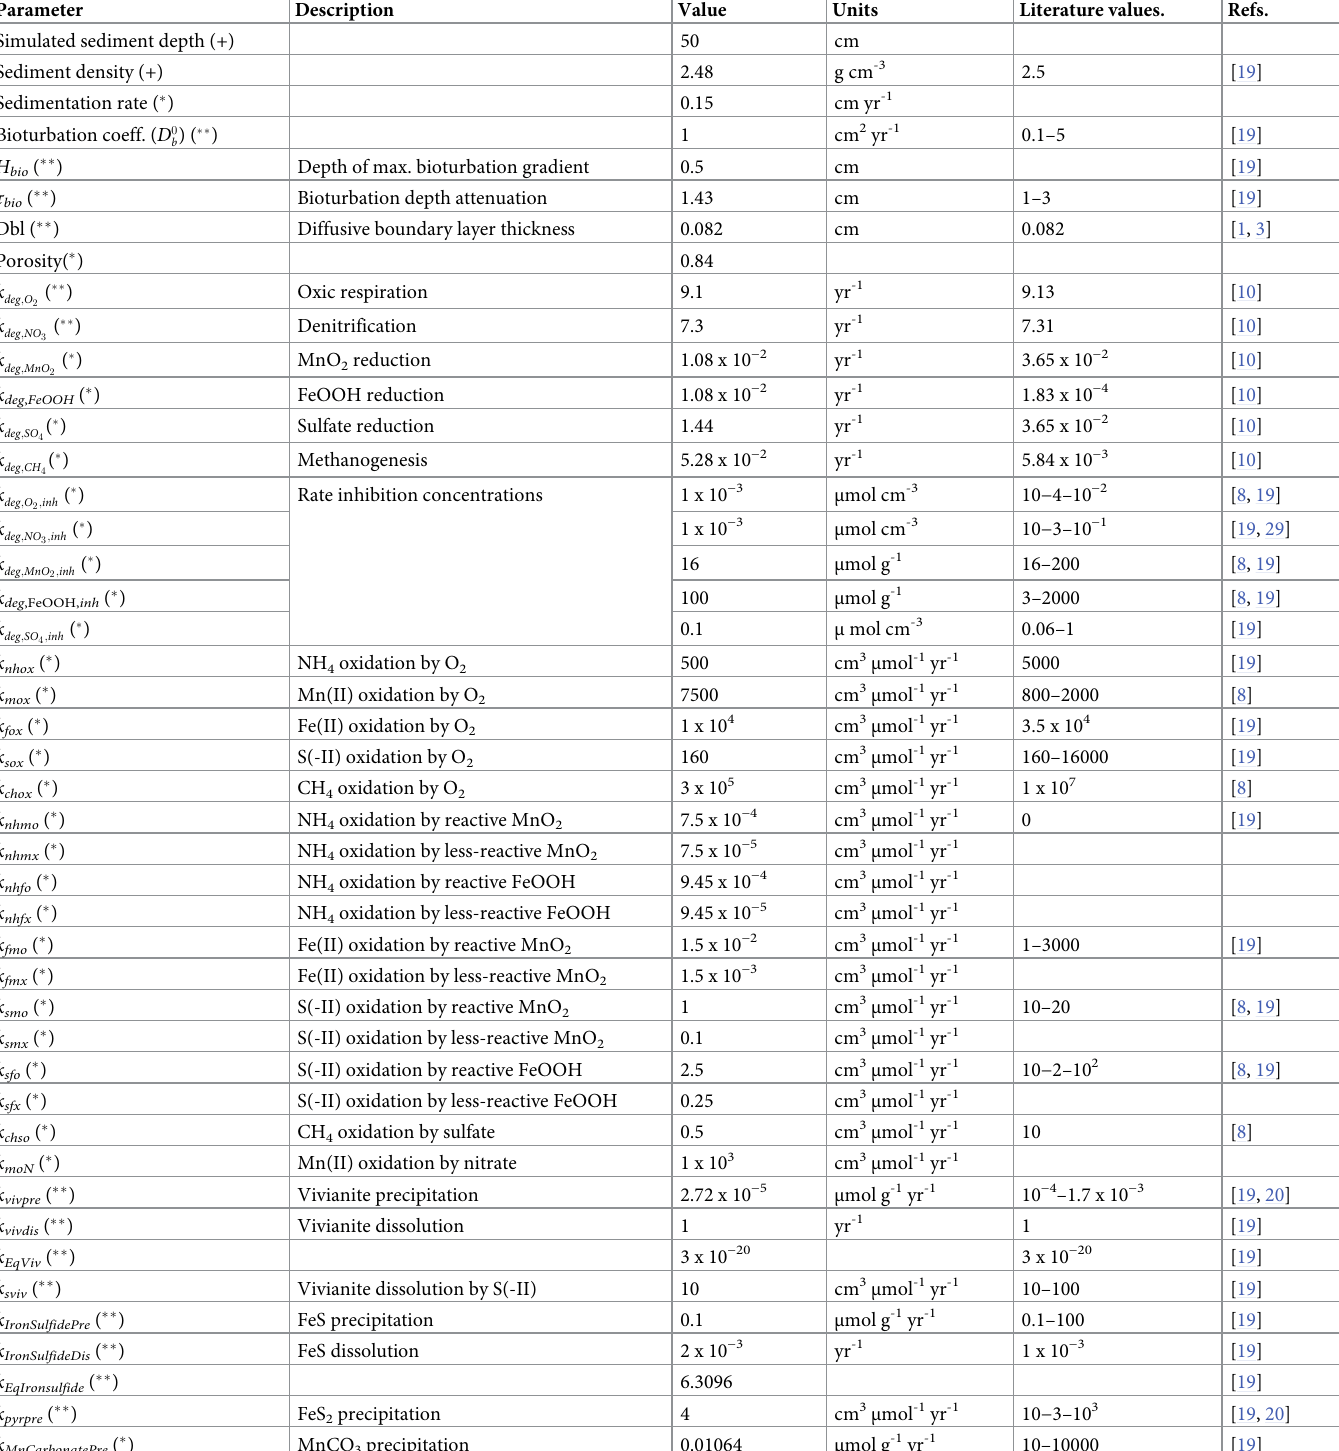
Table 3. Model parameters used in the model. The reaction rates and corresponding reactions are defined in the S1 and S2 Tables. The asterisks are used to distinguish between calibrated ( � ), literature ( �� ) or measured (+)